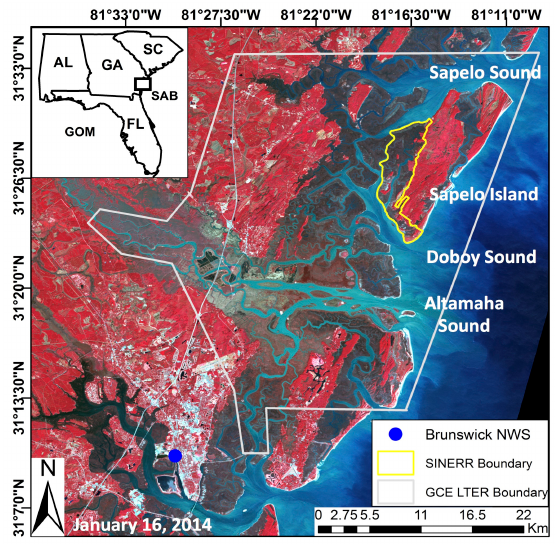
Figure 1. Landsat 5 color infrared image of the Brunswick National Weather Service (NWS) station, Sapelo Island National Estuarine Research Reserve (SINERR), and Georgia Coastal Ecosystems Long Term Ecological Research (GCE LTER) sites in Georgia.